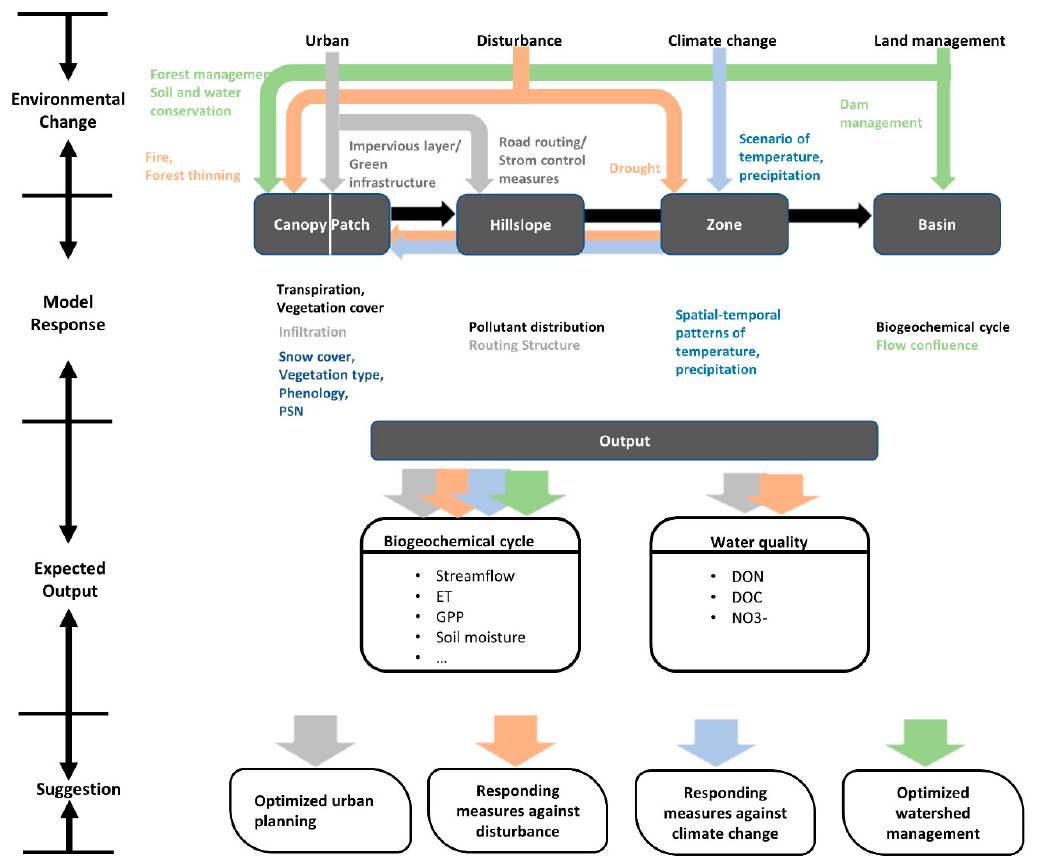
Figure 8. Conceptual framework of RHESSys research for different topics.